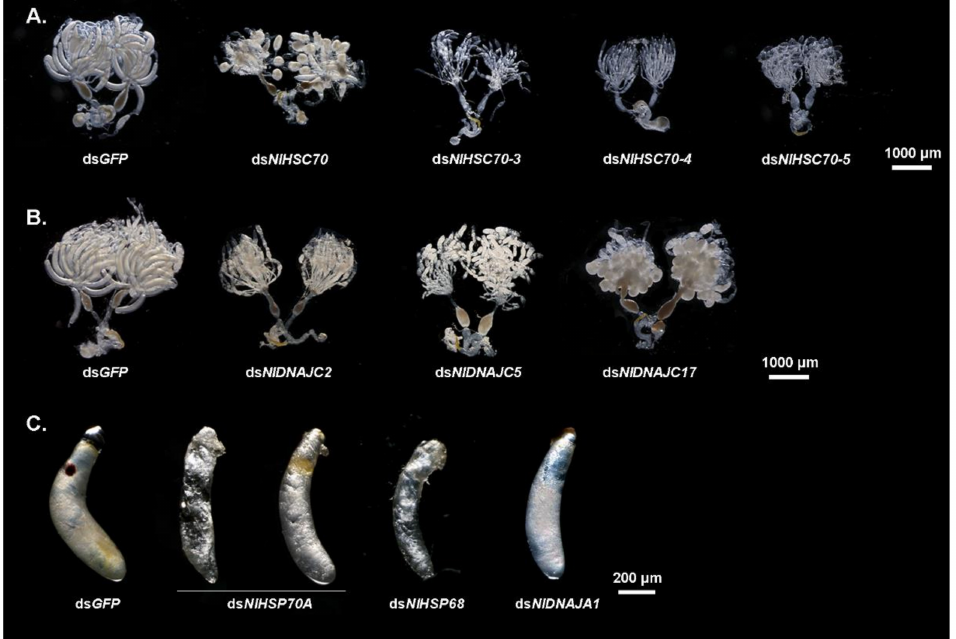
Figure 6. Effects of dsRNA treatments on ovary and embryonic development. ( A ) Ovaries dissected from ds NlHSC70 -, ds NlHSC70-3 -, ds NlHSC70-4 -, and ds NlHSC70-5 -treated females at 3 days after adult eclosion. ( B ) Ovaries dissected from ds NlDNAJC2 -, ds NlDNAJC5 -, and ds NlDNAJC17 -treated females at 3 days after adult eclosion. ds GFP was used as the negative control. ( C ) Embryonic development after injection with dsRNA on day 5. The eggs laid by ds GFP -treated females served as the parallel